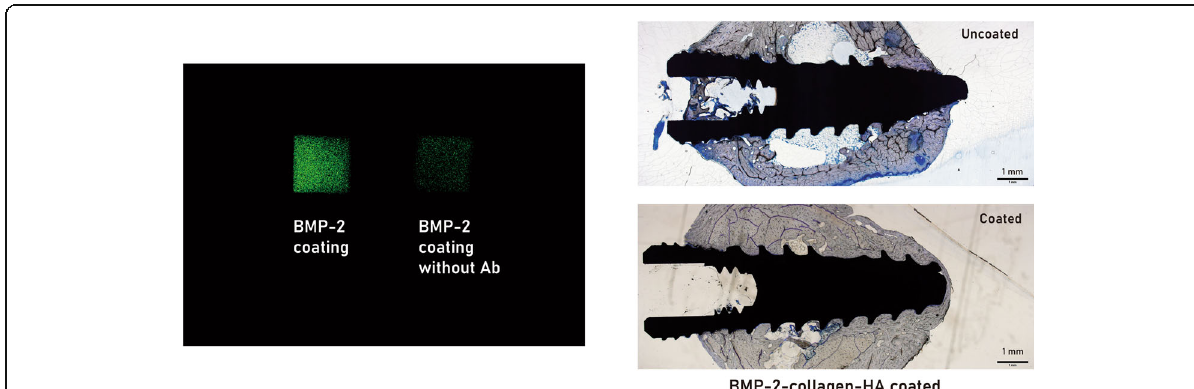
Fig. 3 Bone morphogenic protein-2 (BMP-2) has been coated on a hydroxyapatite (HA)-coated titanium surface. Successful incorporation is confirmed by immunofluorescence image (left). When applied anti-BMP-2 antibody with green fluorescence, BMP-2 coated plate showed high signal intensity. However, the same kind of plate without application of anti-BMP-2 antibody showed low signal intensity. BMP-2, collagen, and HA combination-coated dental implant shows better peri-implant bone formation compared to the uncoated dental implant